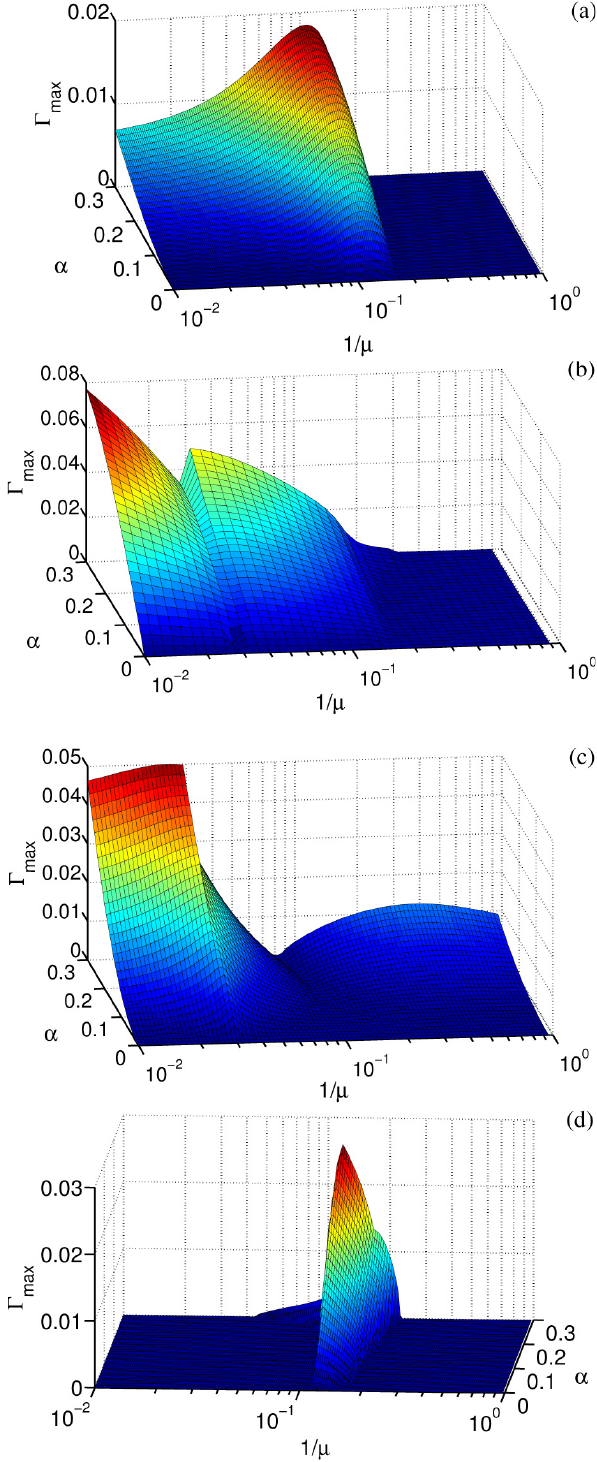
Fig. 13. (Color online) Maximum growth rate for various pump wave amplitudes α and temperatures 1 /µ . Notice that the scale is logarithmic scale for temperature. (a) Crossing (2), ( p + , e − ). (b) Crossing (3), ( S + , p − ). (c) Crossing (4), ( p + , p − ). (d) Crossing (5), ( e − , p −